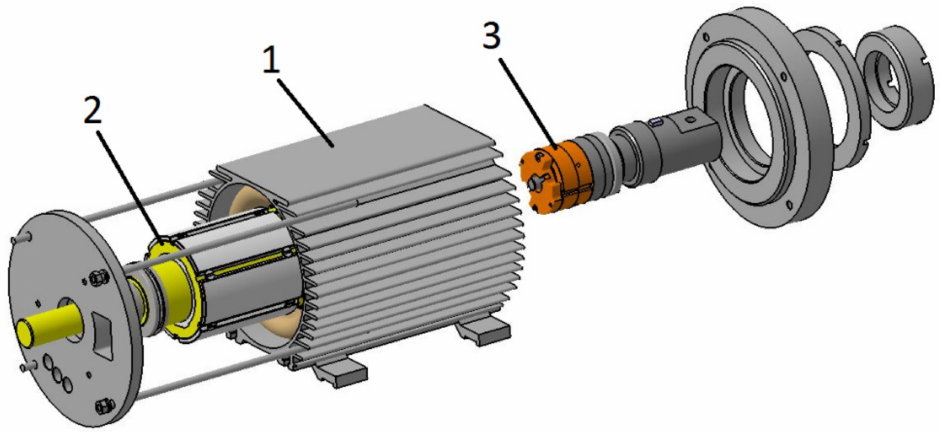
Figure 4. Vane pump integrated with BLDC motor. 1—stator, 2—rotor of electric motor, 3—pump